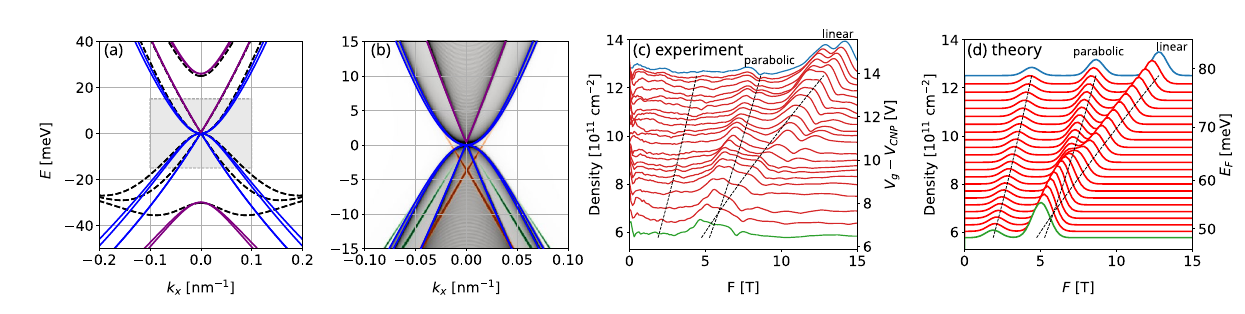
Figure 5. ( a ) Bulk and ( b ) edge energy dispersions for the nominal experimental parameters of the triple 6.7 nm and t 3.0 nm, which falls close to the phase transition line, shaded rectangle quantum well, i.e., d 0 = = in Fig. 2b. The lines and colors follow the same definitions as in Fig. 3. The system is in phase I, with the E 0 1 and H 0 1 subbands hybridized with nearly vanishing mass ˜ M 0 , yielding a linear pair of Dirac subbands (all the subbands are spin-degenerate). ( c ) The Fourier transform of the measured Shubnikov-de Haas oscillations show two main peaks splitting with increasing V g and a further Rashba-like splitting at high V g . ( d ) The theoretical SdH frequencies F for the linear and parabolic subbands from panel ( a ) qualitatively matches the experimental measurements. In both ( c ) and ( d ), the dashed lines mark F j ( E F ) for each subband with E > 0 from panel ( a ) and the peaks are built from gaussian broadenings for easy comparison with panel ( c